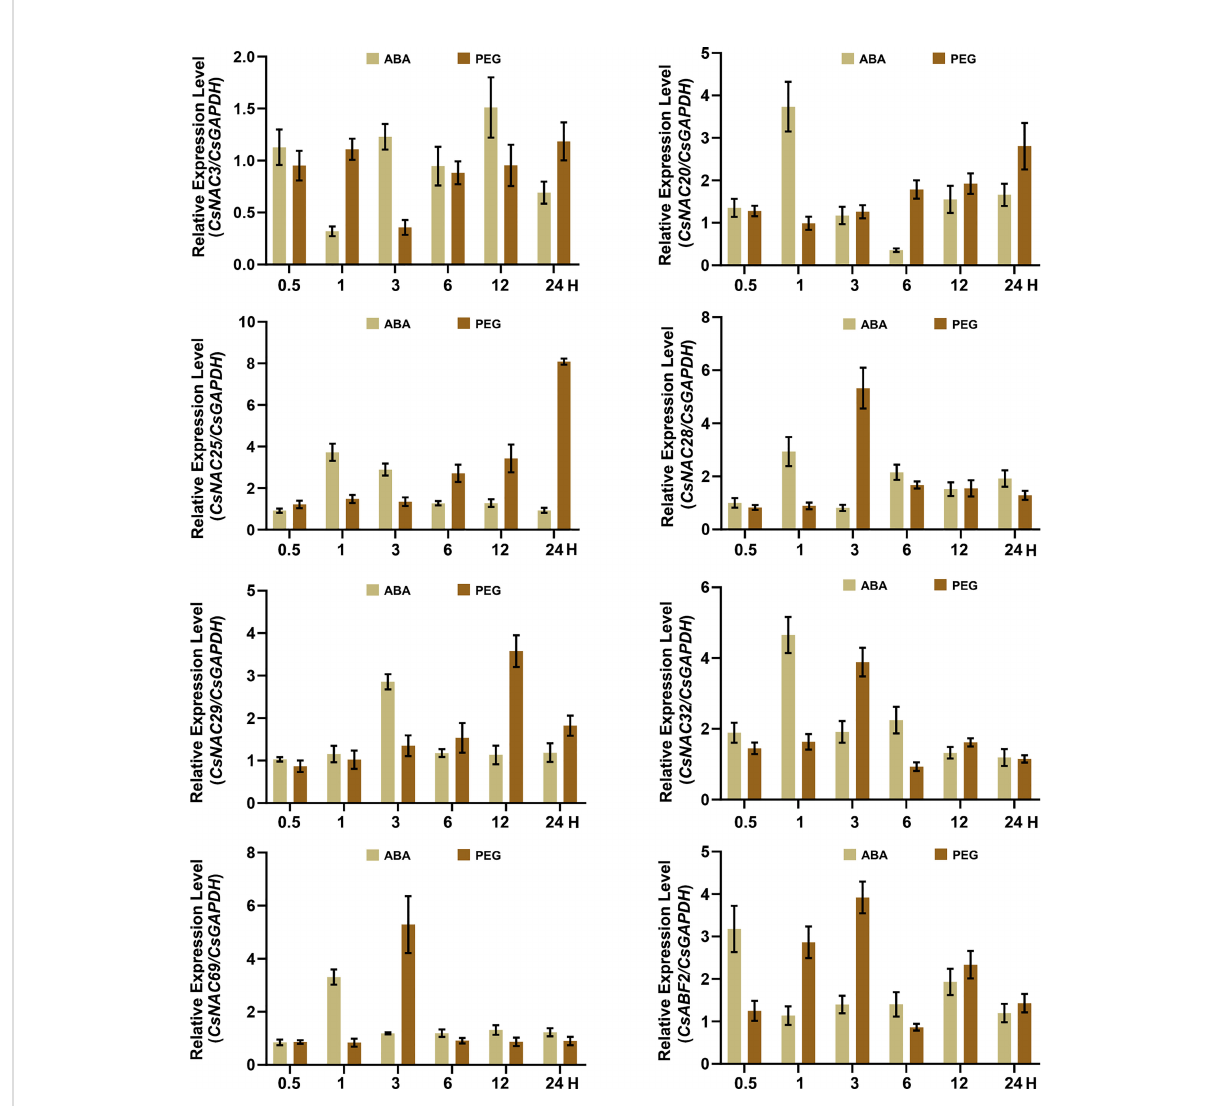
FIGURE 5 Expression patterns of CsNACs in C. sinensis under ABA and PEG. Error bars indicate SD of three biological